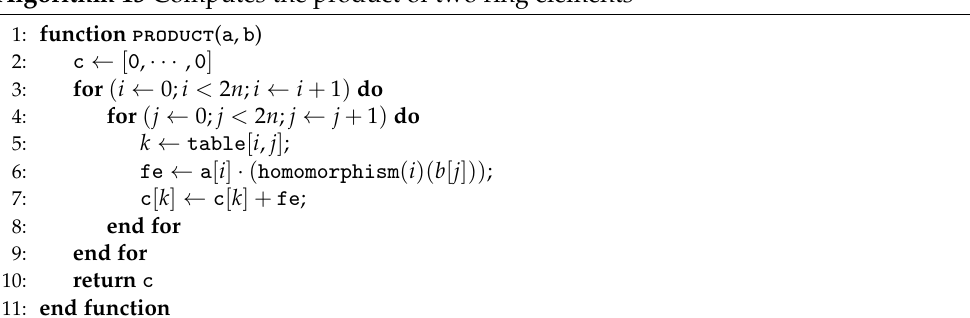
Algorithm 13 Computes the product of two ring elements